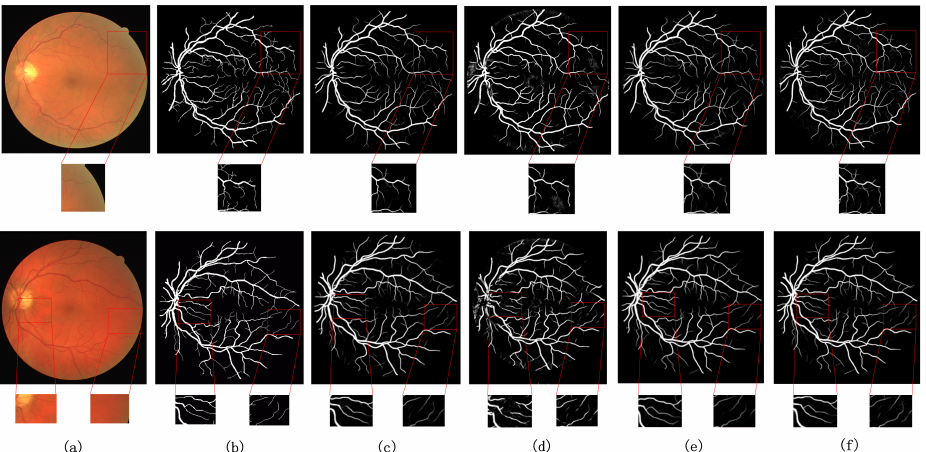
Figure 9. Comparison of visualization results with other methods on DRIVE dataset ( a ) original image, ( b ) groundtruth image, ( c ) UNet++ [13], ( d ) CA-Net [9], ( e ) AG-UNet [52], ( f ) Ours.